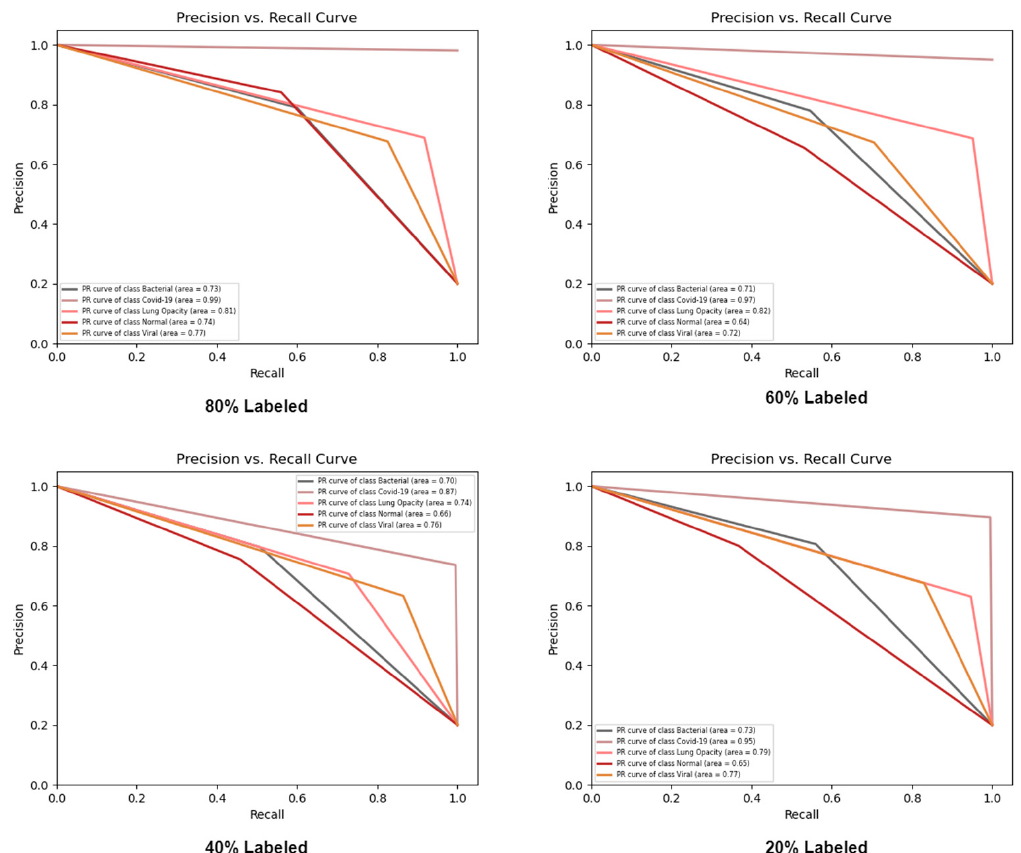
Figure 2. Precision vs. recall curves.